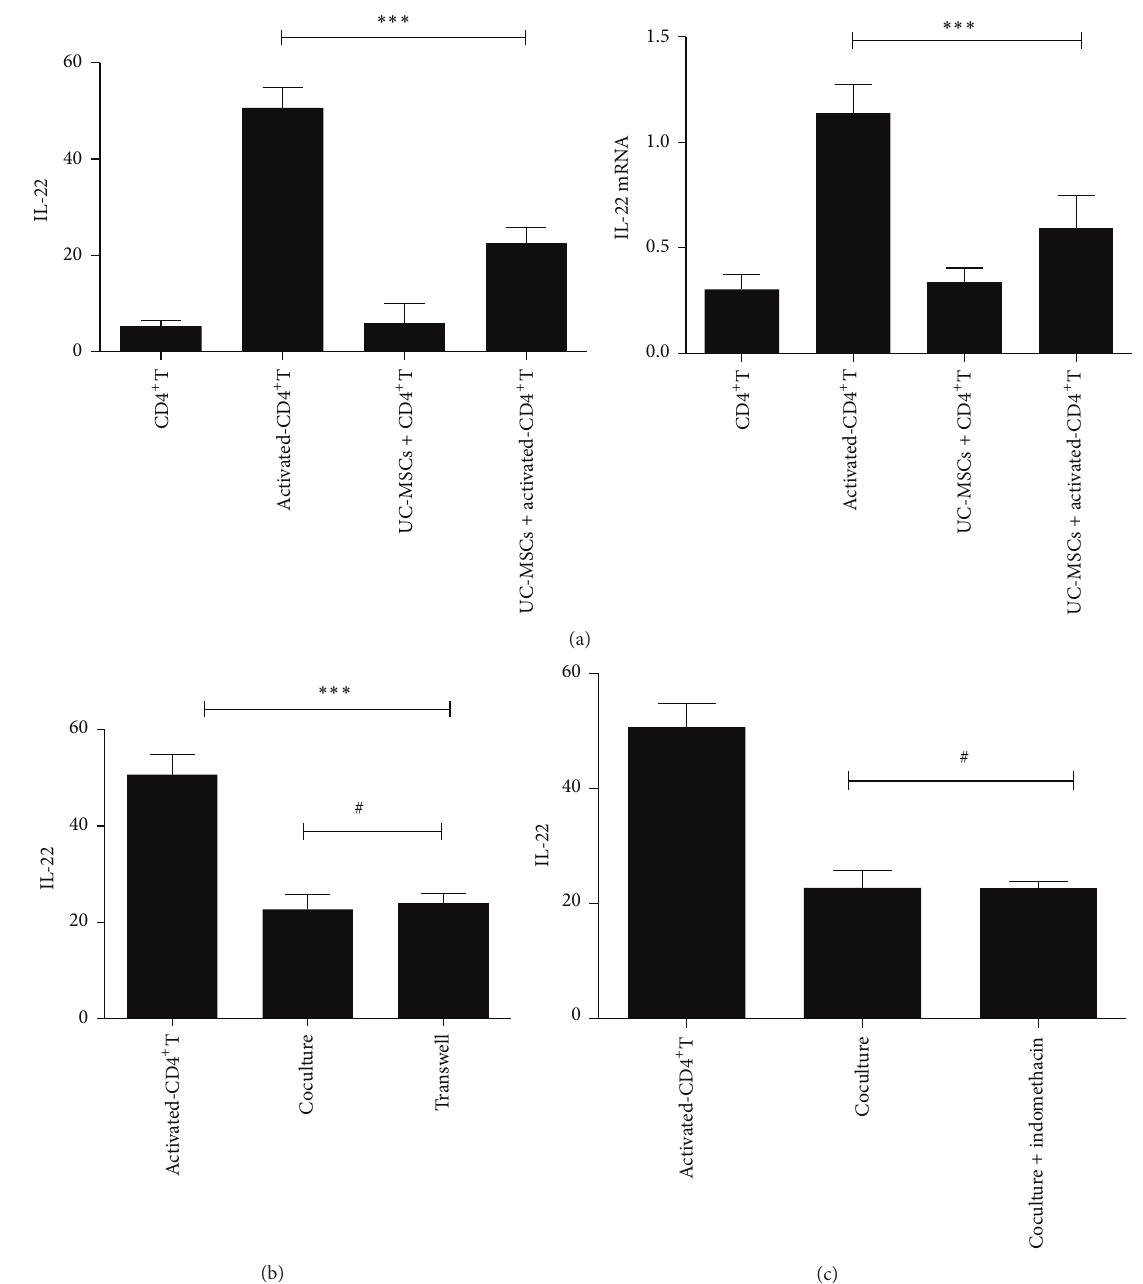
Figure 4: UC-MSCs immunosuppressed IL-22 by soluble cellular factors but not PGE2. (a) UC-MSCs inhibited CD4 + T cells secreting IL-22 and the expression of IL-22 mRNA; (b) the immunoregulation of UC-MSCs on IL-22 was mediated by soluble cellular factors; (c) PGE2 did not involve in the immunoregulation of UC-MSCs on IL-22. Data represent one of the three independent experiments, each performed in triplicate. ∗∗∗ 𝑃 < 0.001 and # 𝑃 > 0.05